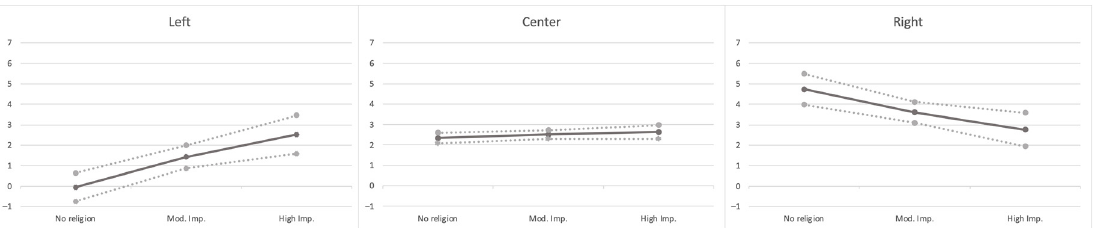
Figure 2. Predicted anger towards Muslims (estimate and confidence interval from Model 2) according to religiosity and political viewpoint: left to right political views. Note: predictions are for the latent underlying anger variable, and therefore allow for predictions outside the bounds of 1 to 7.